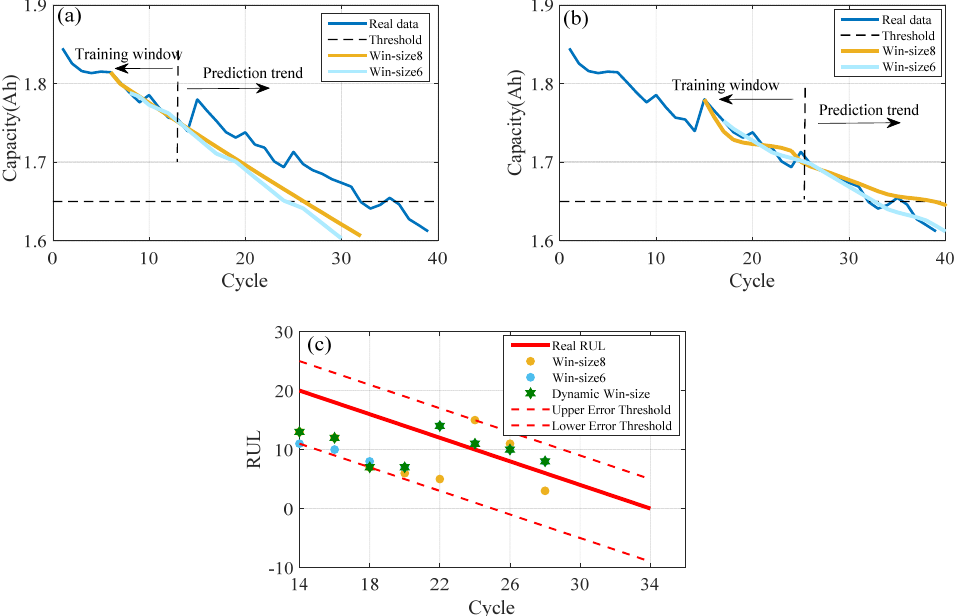
Figure 4. RUL prediction results of No. 32 with a dynamic window size: ( a ) prediction starting cycle of 13; ( b ) prediction starting cycle of 25; ( c ) RUL prediction results.